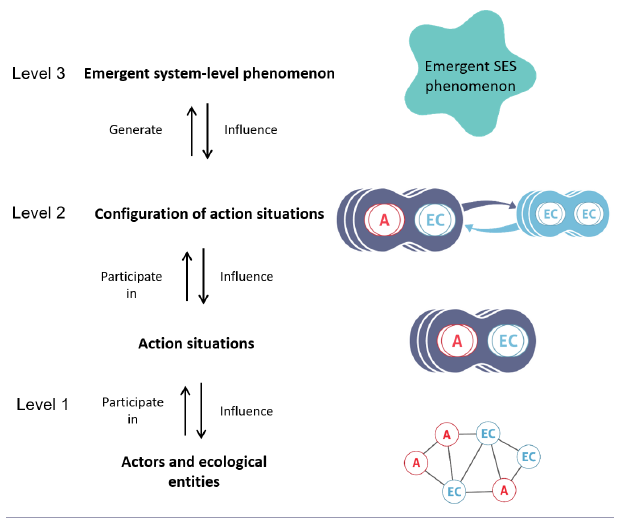
Fig. 2 . Different levels of analysis of interactions and emergent outcomes in a social-ecological system (SES) that form the basis of our social-ecological action situations (SE-AS) framework. Framework components are actors and ecological entities organized in action situations (AS; level 1). In the second level, AS influence each other through emergent outcomes (level 2) to jointly produce the phenomenon of interest (level 3). Influence can go across all levels from bottom to top but also from top to